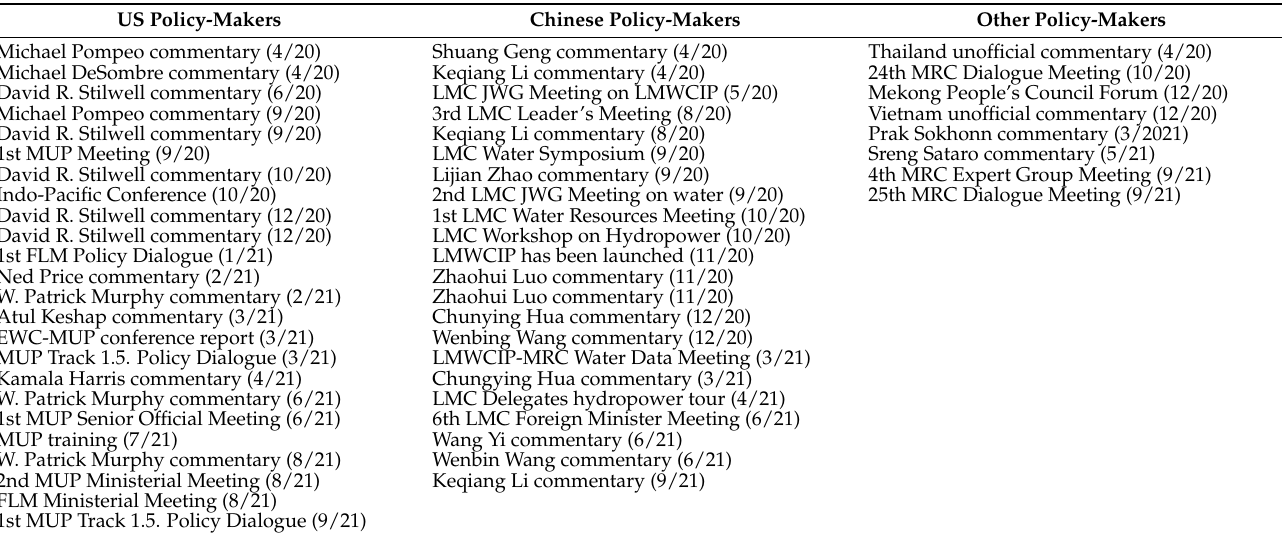
Table 3. List of policy-makers inputs de/politicizing the Chinese mainstream dams